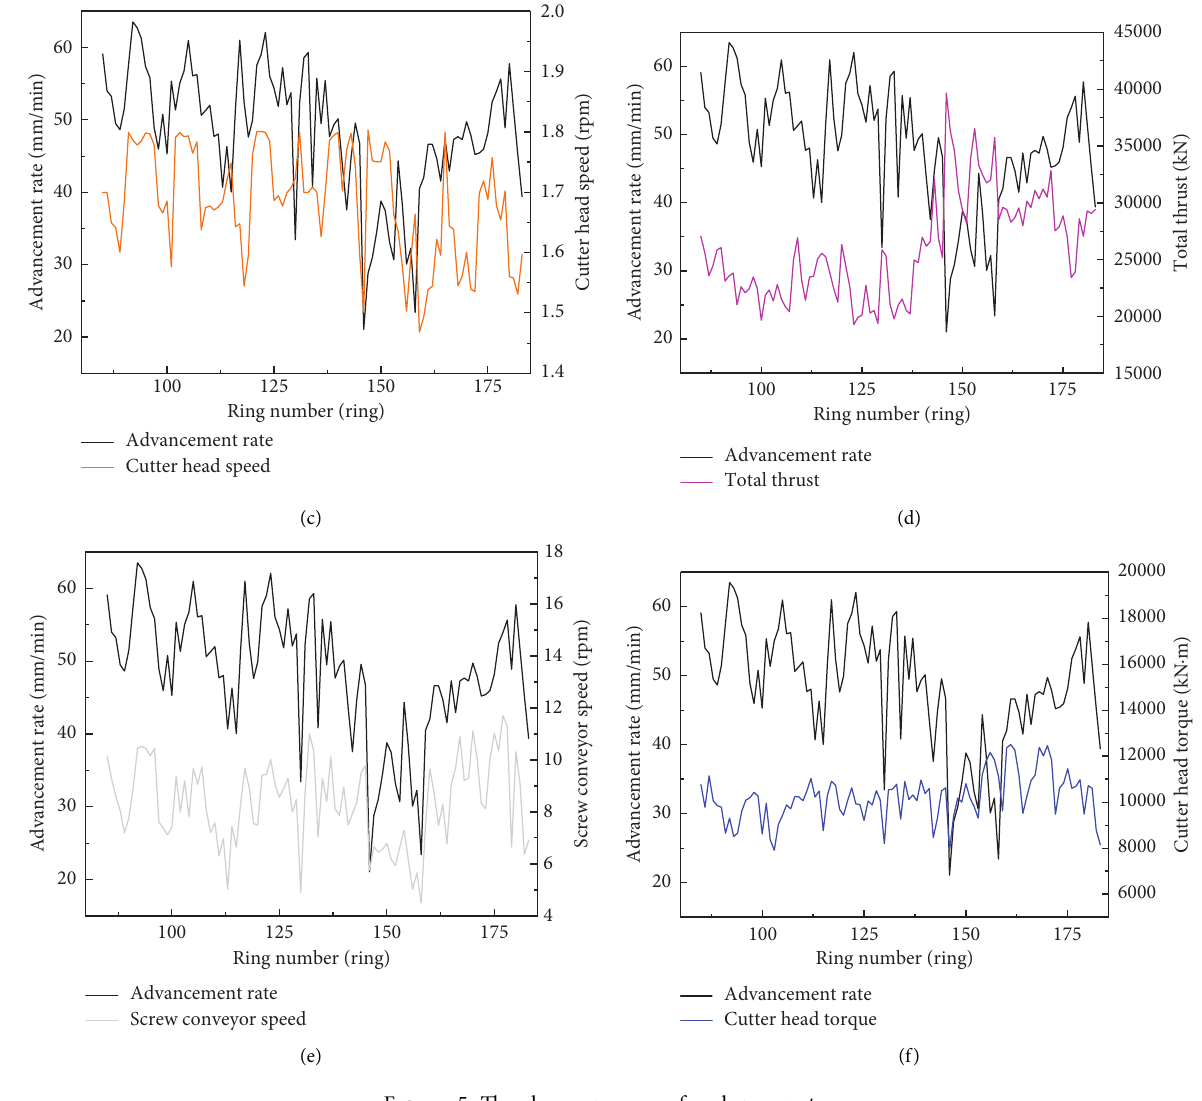
Figure 5: The change process of each